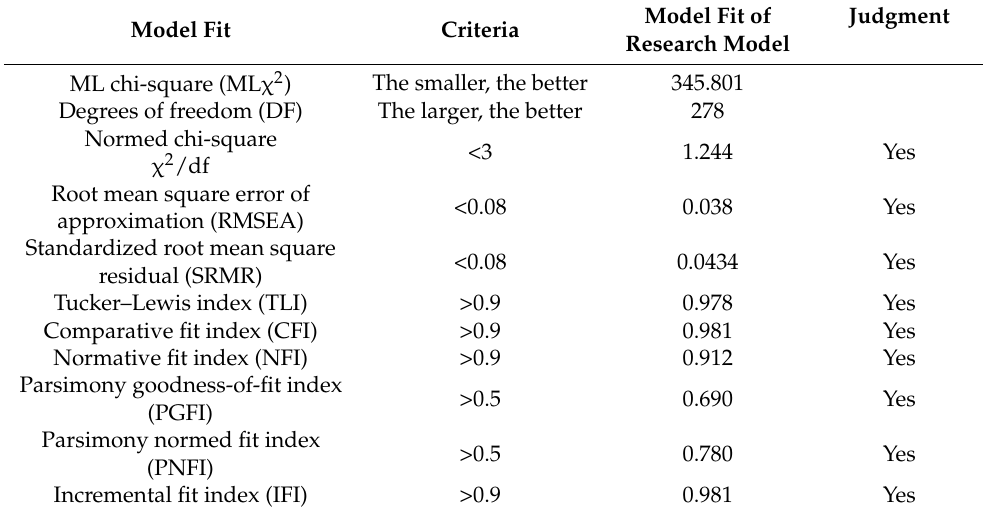
Table 8. Model fit